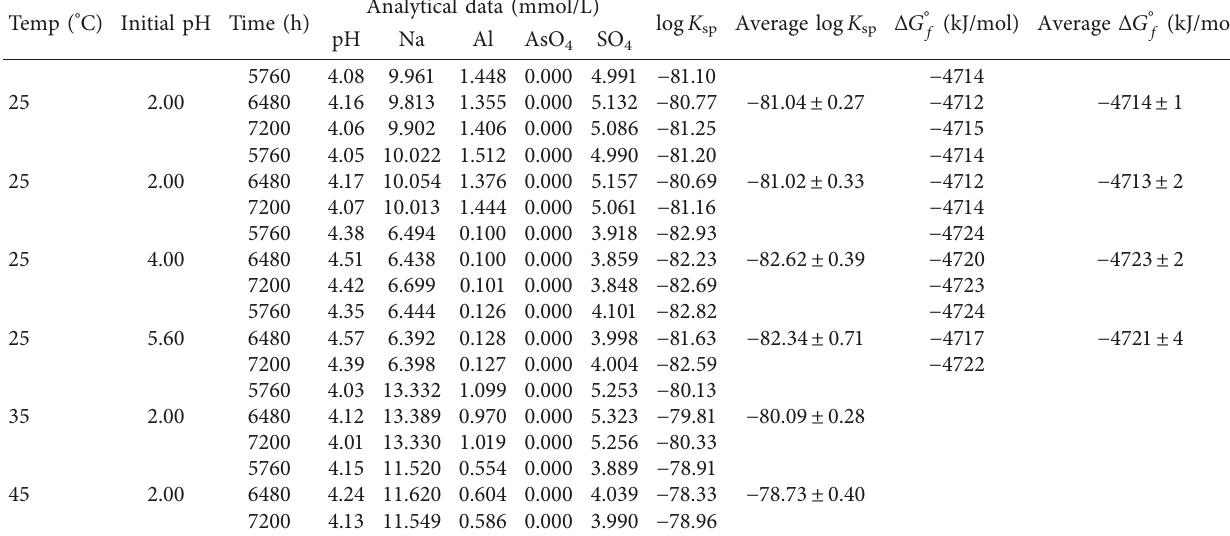
0.93 (H 3 O) 0.61 Al 2.82 (SO 4 ) 2 (OH) 6 ].